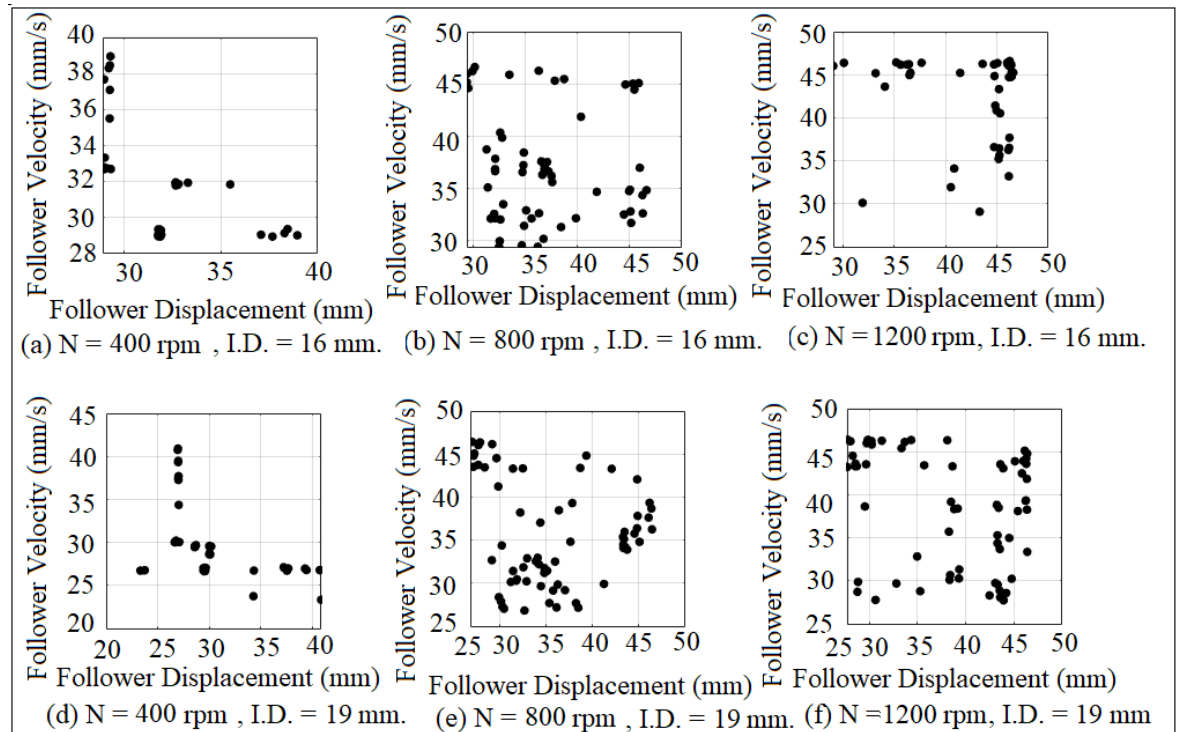
Figure 23. Poincaré maps of chaotic attractor when the follower offsets to the right (O = 50 mm). Figure 23. Poincar é maps of chaotic attractor when the follower offsets to the right (O = 50 mm).